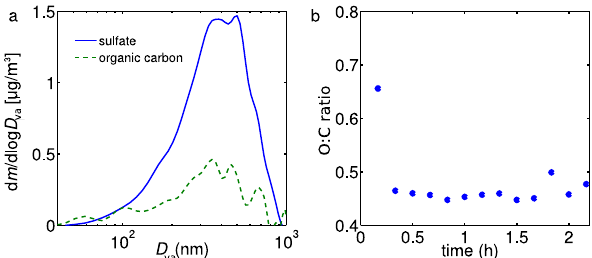
Fig. 3. (a) Mass size distribution d m/ dlog D va (µgm − 3 ) of sulfate (blue curve) and organic carbon (green curve) as a function of vac- uum aerodynamic diameter D va . (b) 10min mean oxygen to carbon radio (O:C) during the first 2h after the injection of ozone in the